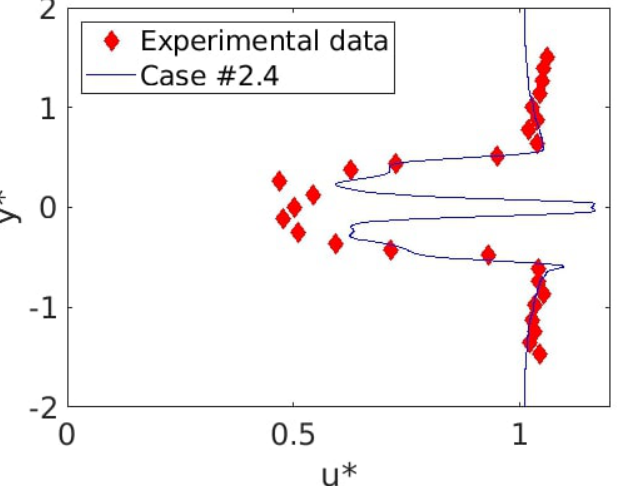
Figure 24. Same legend as for previous figure, but profiles were taken at x ∗ = 2. The mismatch at y ∗ = 0 was due to the missing hub in the numerical case.